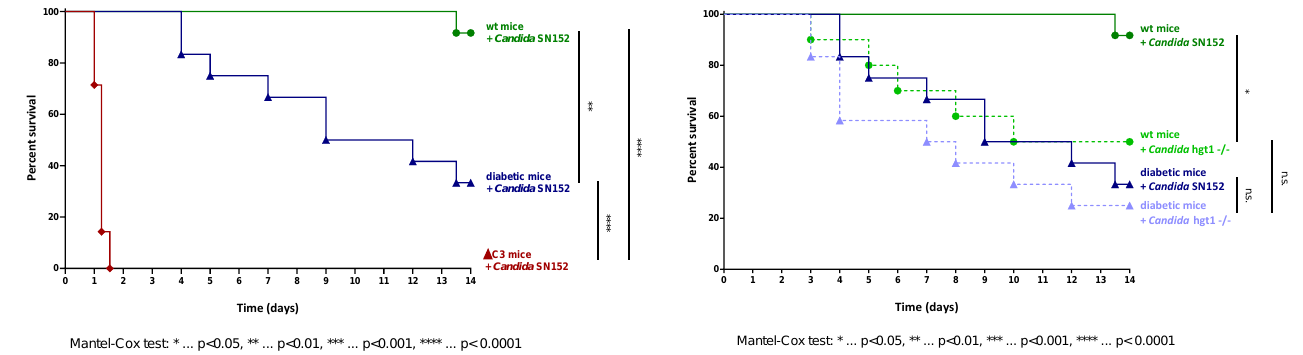
Figure 1. Survival curves in a murine model of candidemia. Euglycemic (wt, n = 12), diabetic ( n = 12), and C3 deficient ( ∆ C3, n = 7) animals were intravenously injected with 6 × 10 2 Candida albicans cells of the parental strain SN152 per gram mouse ( A ). Survival curves of wt (n Candida SN152 = 12, n Candida hgt1-/- = 8) and diabetic animals ( n = 12) challenged with 6 × 10 2 yeast cells of either Candida albicans SN152 (―) or the HGT1 knockout mutant (hgt1-/-, ----) per gram mouse were compared ( B ). The survival was monitored for 14 days. Stars (*) indicate the level of significance for a p -value resulting from a Mantel–Cox test analyzing pairs of survival curves.